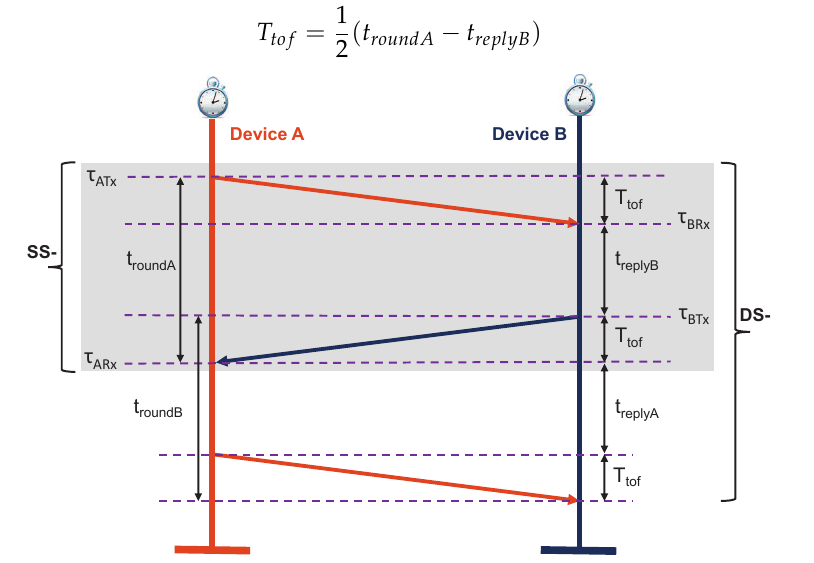
Figure 1. Illustration of single- and double-sided Two-Way Ranging (TWR) methods ( c (cid:13) 2018 IEEE. Reprinted with